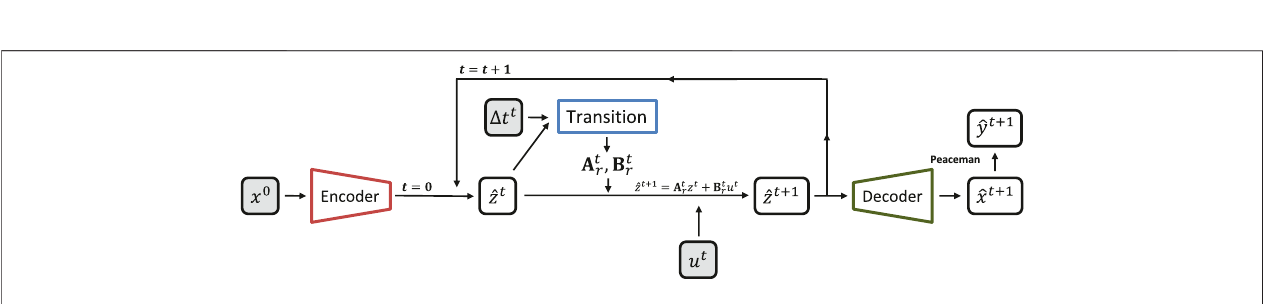
FIGURE 6 | E2C prediction diagram (propositions 1 and 2).